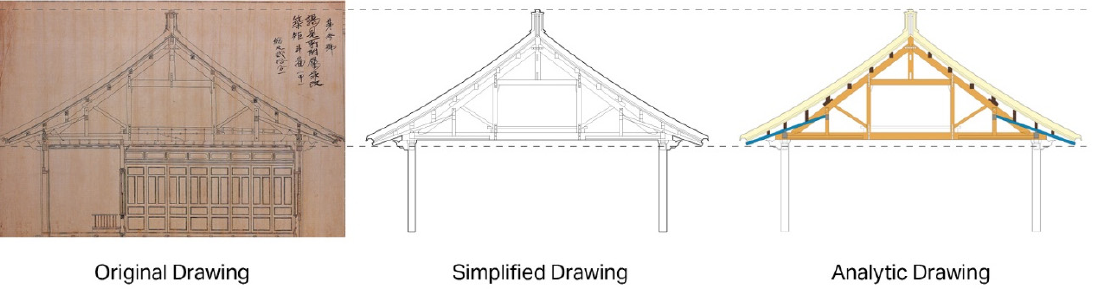
Figure 11. Process of Preparing Analytic Diagrams (Members used for Basic Structural Frame: Yellow; Members used for Protruding Eaves: Blue; Members used for Creating Roof Curve: Dark Brown; Roof Surface: Light Brown; Other Supplementary Diagonal Members: Gray).